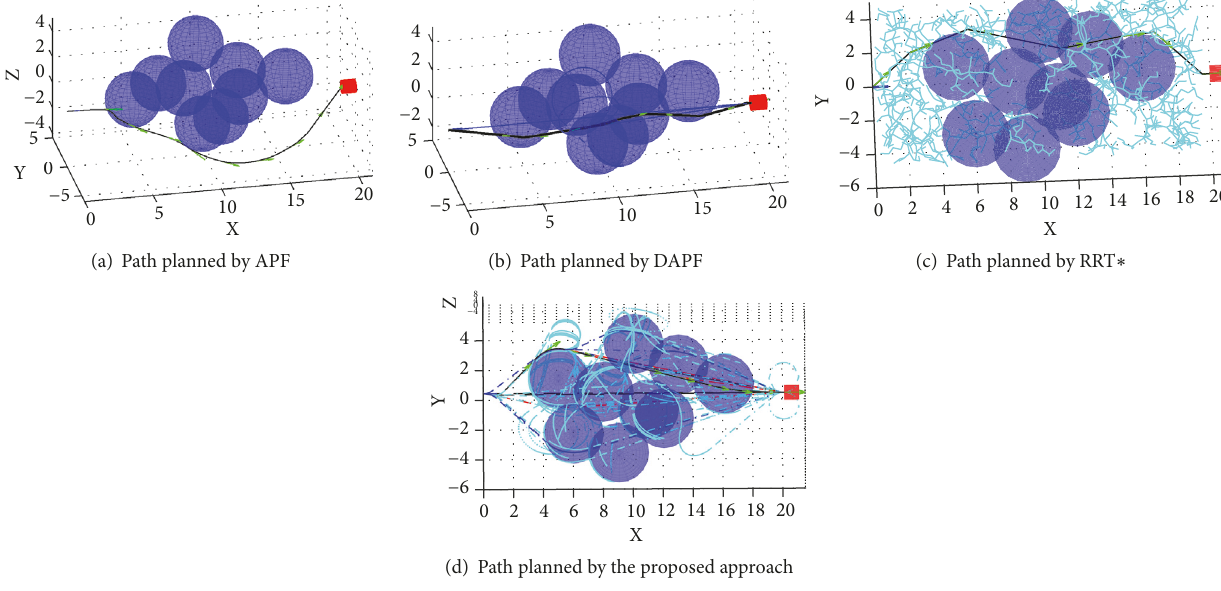
Figure 8: Simulation results of the path planning approaches in case 1, scenario